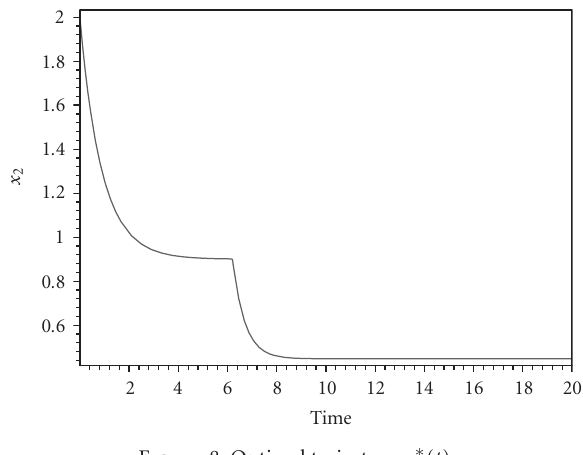
Figure 8: Optimal trajectory x ∗ 2 ( t